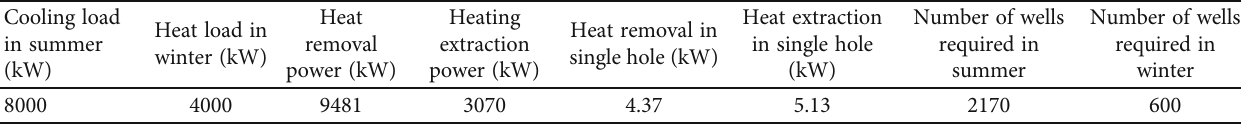
Table 5: Number of heat source wells required for a building with an area of one hundred thousand square meters. Cooling load